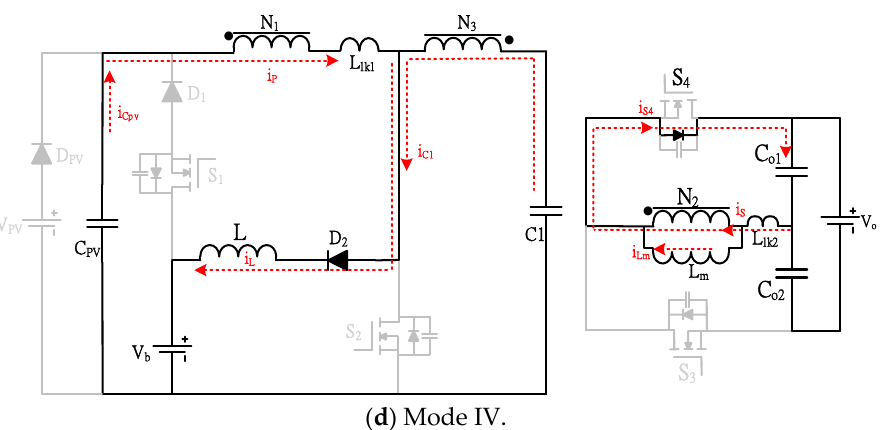
Figure 8. Operational diagram of each mode in Stage 3: ( a ) Mode I, ( b ) Mode II, ( c ) Mode III, and ( d ) Mode IV.